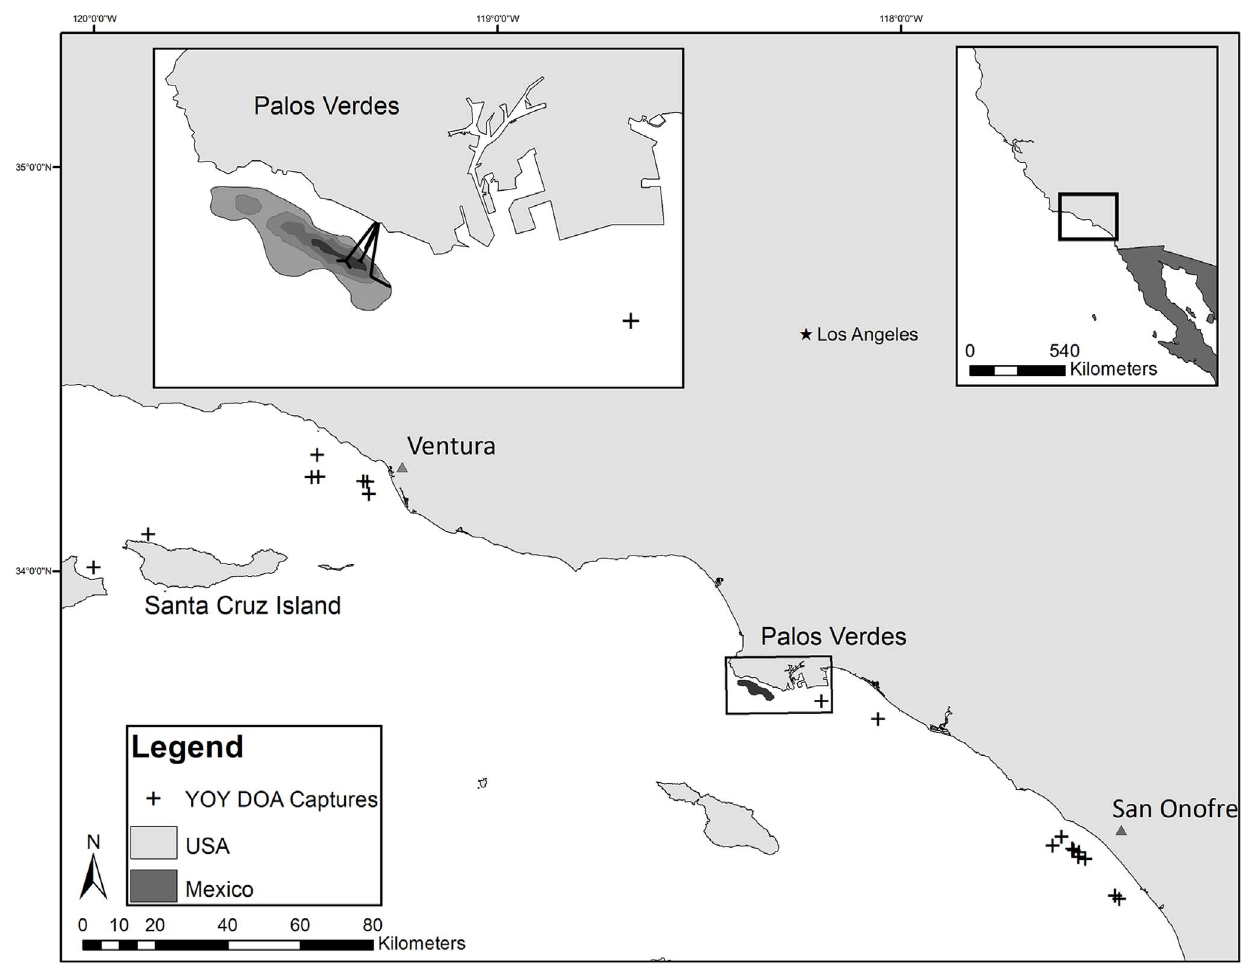
Figure 1. Map of the study area in the Southern California Bight (SCB). Black crosses denote the capture location of each individual used in this study. The shaded area represents the Palos Verdes Shelf Superfund Site where large amounts of DDT and PCBs were discharged with effluent and constitute a large portion of the legacy contaminants in the SCB.